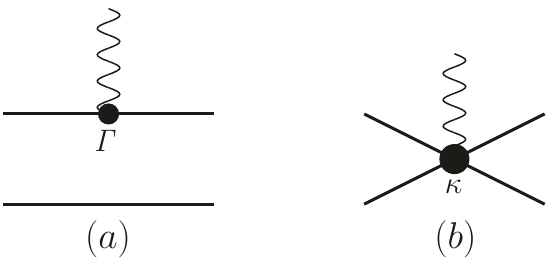
Figure 2 . Diagrams contributing to the kernel ˜ Γ which, convoluted with the wave functions ¯Ψ , Ψ , yields the resonance form factor, see eq. (2.23). The troublesome triangle diagram (a) in the finite-volume form factor, mentioned in the Introduction, emerges from the disconnected part, where the photon is attached to one of the particles, whereas the second one acts as a spectator. The fully connected diagram (b), where the photon is emanated from the four-particle vertex, is